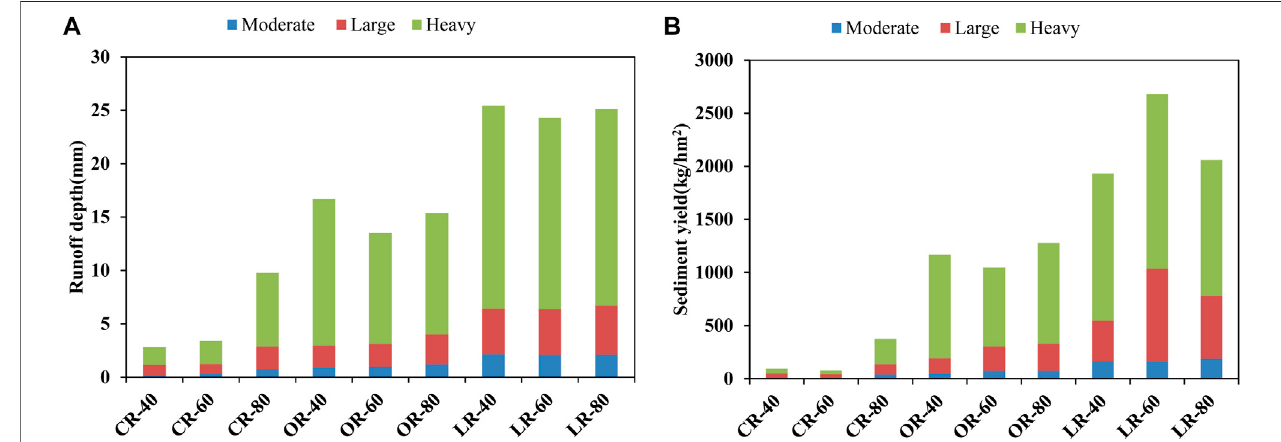
FIGURE13 | Runoff depth (A) and sediment yield (B) of different treatmentsunder different rainfall patterns, and CR-40, CR-60, and CR-80 represent cross-ridge tillagewith40,60,and80 cmridgewidth,respectively.OR-40,OR-60,andOR-80 representoblique-ridgetillagewith40,60,and80 cmridgewidths,respectively.LR- 40, LR-60, and LR-80 represent longitudinal-ridge tillage with 40, 60, and 80 cm ridge widths, respectively. Moderate, large, and heavy represent moderate, large, and heavy rainfall patterns, respectively.